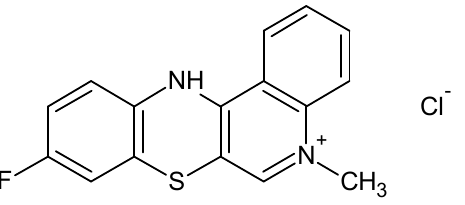
Figure 1. 9-Fluoro-5-alkyl-12(H)-quino [3,4-b][1,4]benzothiazinium chloride (Salt2)